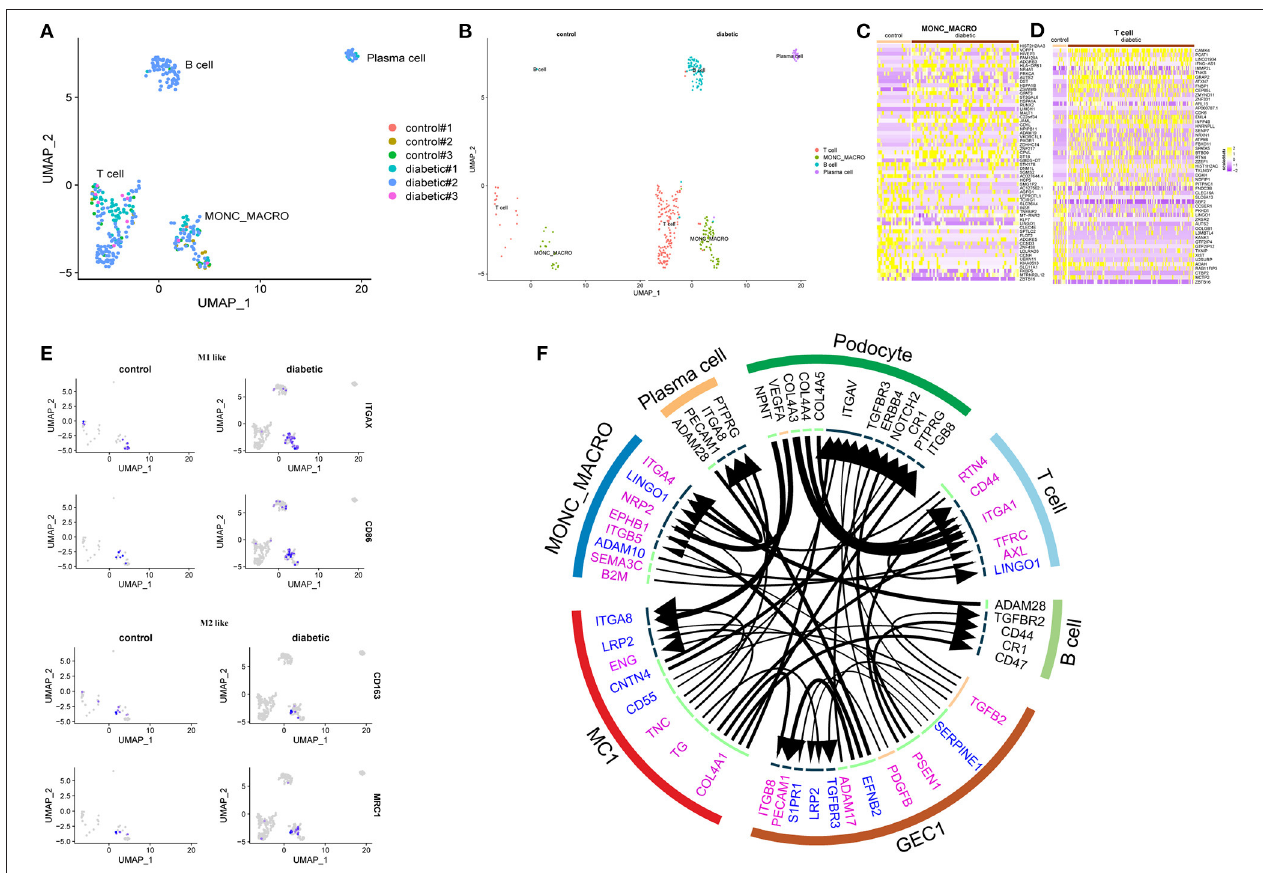
FIGURE 2 | (A) UMAP plot of the distribution of immune cells in different samples. (B) UMAP plot of four subclusters of immune cells. (C) Heatmap of top 30 up- and down-regulated DEGs in monocytes/macrophages. (D) Heatmap of top 30 up- and down-regulated DEGs in T lymphocytes. (E) Distribution of selected cell markers of monocyte/macrophage: (Upper) Presence of M1-like macrophage markers (ITGAX and CD86) and (Lower) M2-like macrophage markers (CD163 and MRC1). (F) Ligand-receptor interactions prediction network with DEGs from GEC1, MC1, monocytes/macrophages (MONO_MACRO), T lymphocytes, and top 500 expressed genes of podocytes, B lymphocytes, and plasma cells. In the circus, upregulated genes are labeled purple; downregulated genes labeled blue; top expressed genes in podocytes, B lymphocytes and plasma cells labeled black. The lines and arrowheads inside are scaled to indicate the correlations of the ligand and receptor. P -value < 0.05 were considered statistically